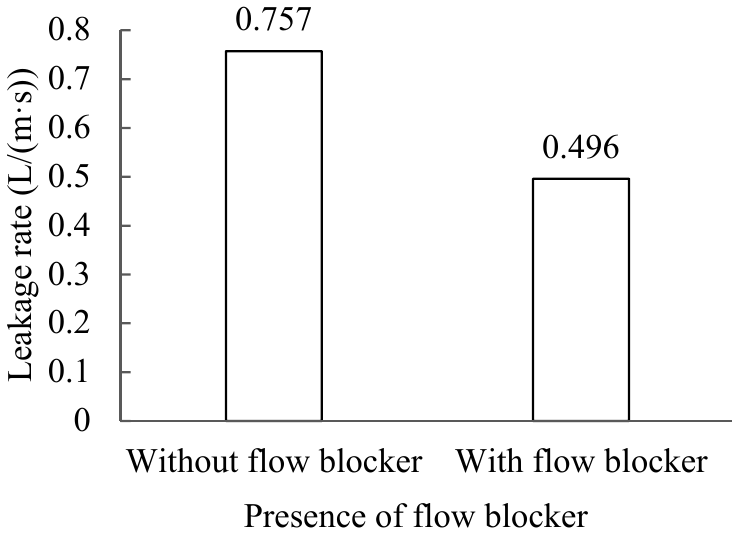
Figure 12. Impact of flow blocker on the leaked-air rate.